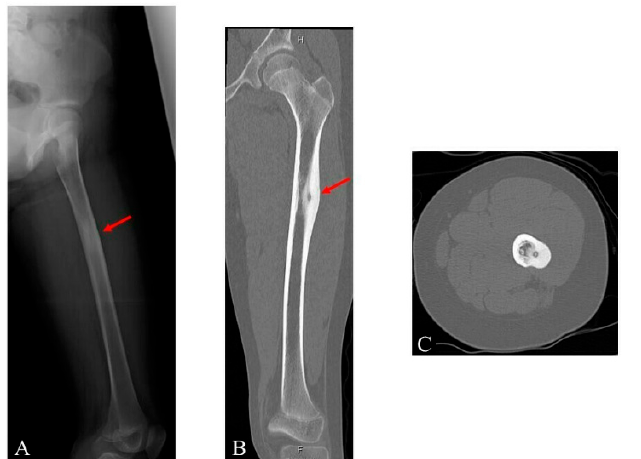
Figure 1. Images of the left femur of a 12-year-old girl: ( A ) radiograph; ( B ) coronal computed tomography (CT) image; and ( C ) axial CT image.